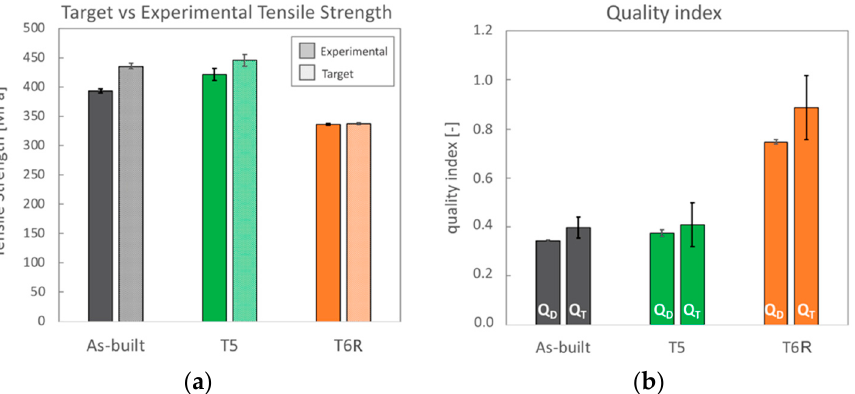
Figure 10. Results from the analyses of the strain hardening behavior AlSi7Mg PBF-LB alloy in the as-built, T5, and T6R temper condition: ( a ) experimental tensile strength obtained from tensile tests compared to the target one; ( b ) quality index (Q D index is based on ductility, Q T index is based on toughness).